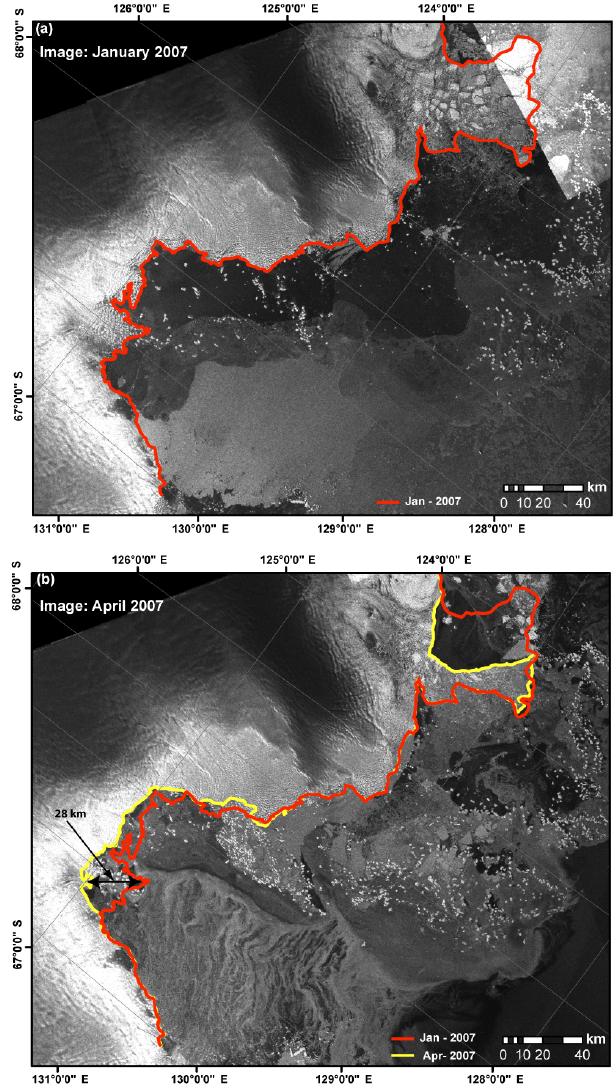
Figure 3. Envisat ASAR WSM imagery in January 2007 (a) and April 2007 (b) , which are immediately prior to and after a near- simultaneous calving event in Porpoise Bay. Red line shows termi- nus positions in January 2007 and yellow line shows the positions in April